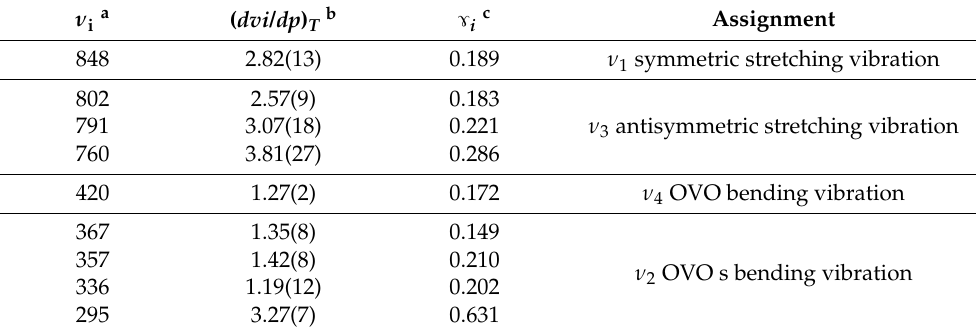
Table 2. Pressure dependences and mode Grüneisen parameters of the measured Raman modes below 18.0 GPa in